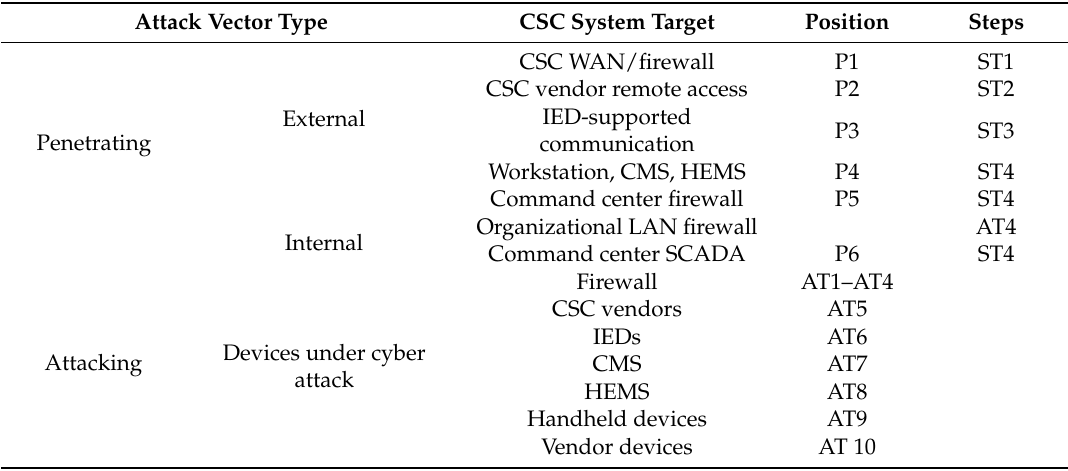
Table 3. Smart grid SCS and potential security